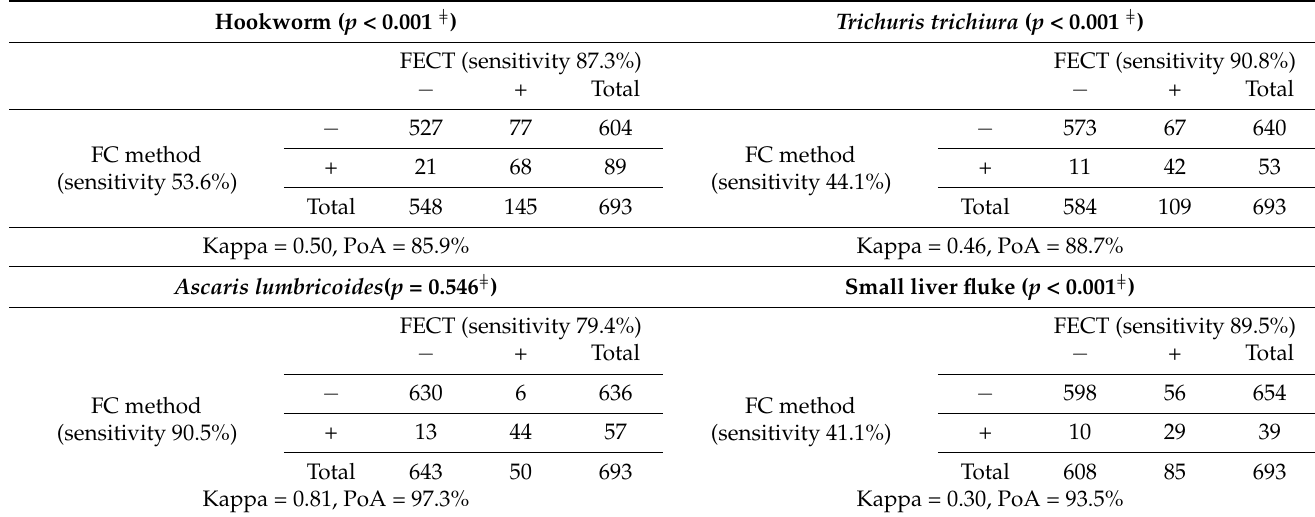
} Comparison of the detection rate between the FECT and FC method ( χ 2 test). FC: formalin concentration; FECT: formalin ethyl-acetate concentration technique; PoA: proportion of